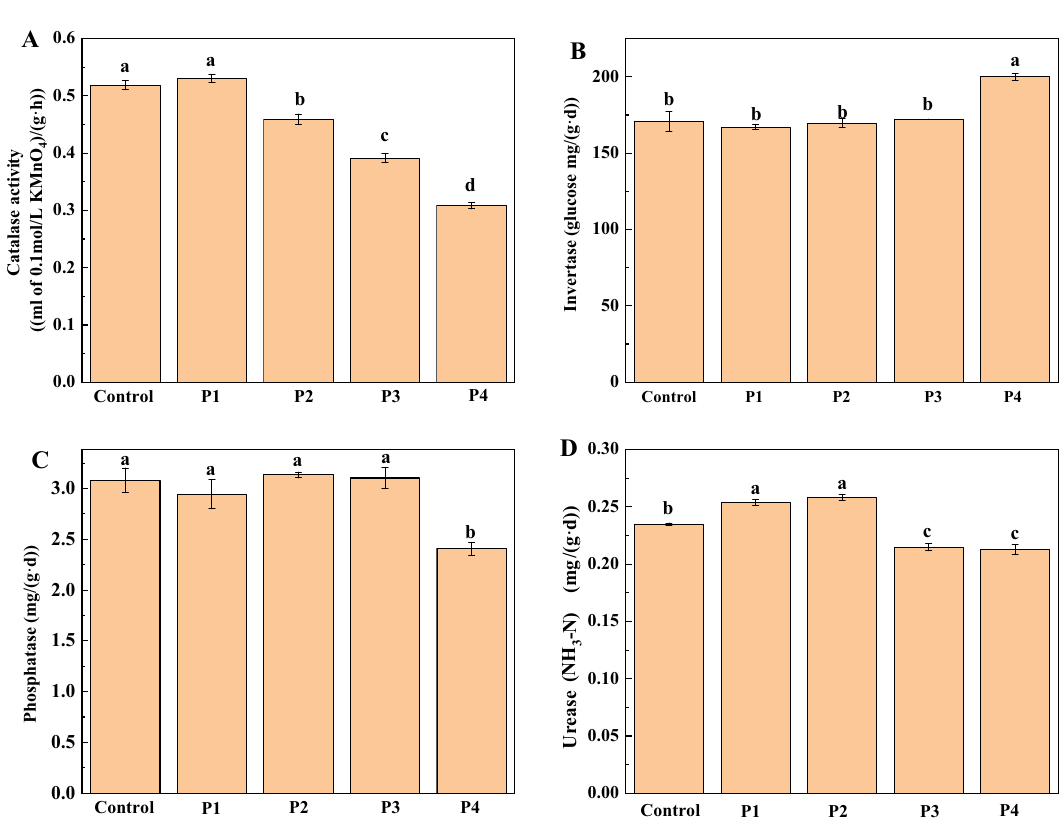
Figure 2. Effect of PG on soil enzyme activity. Catalase ( A ), Invertase ( B ), Phosphatase ( C ) and Urease ( D ). Different lowercase letters represent significant differences at the level of P <